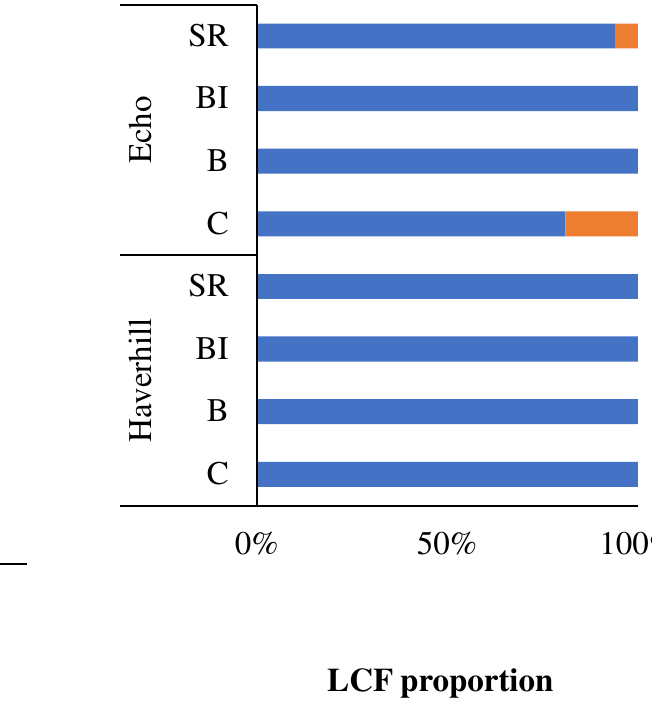
Figure 4. ( A ) Normalized Zn XANES K-edge spectra of post-harvest soils collected from landscape- based Zn fertilization field trials in south-central Saskatchewan conducted on Haverhill (upslope) and Echo (downslope) soil associations in a farm field. ( B ) Results of linear combination fit, showing the relative changes in Zn speciation among treatments. Treatments are C: unfertilized control; B: broadcast Zn; BI: broadcast and incorporation Zn; and SR: seed row banding of sulfate form of Zn fertilizer at the rate of 2 kg ha −1 .